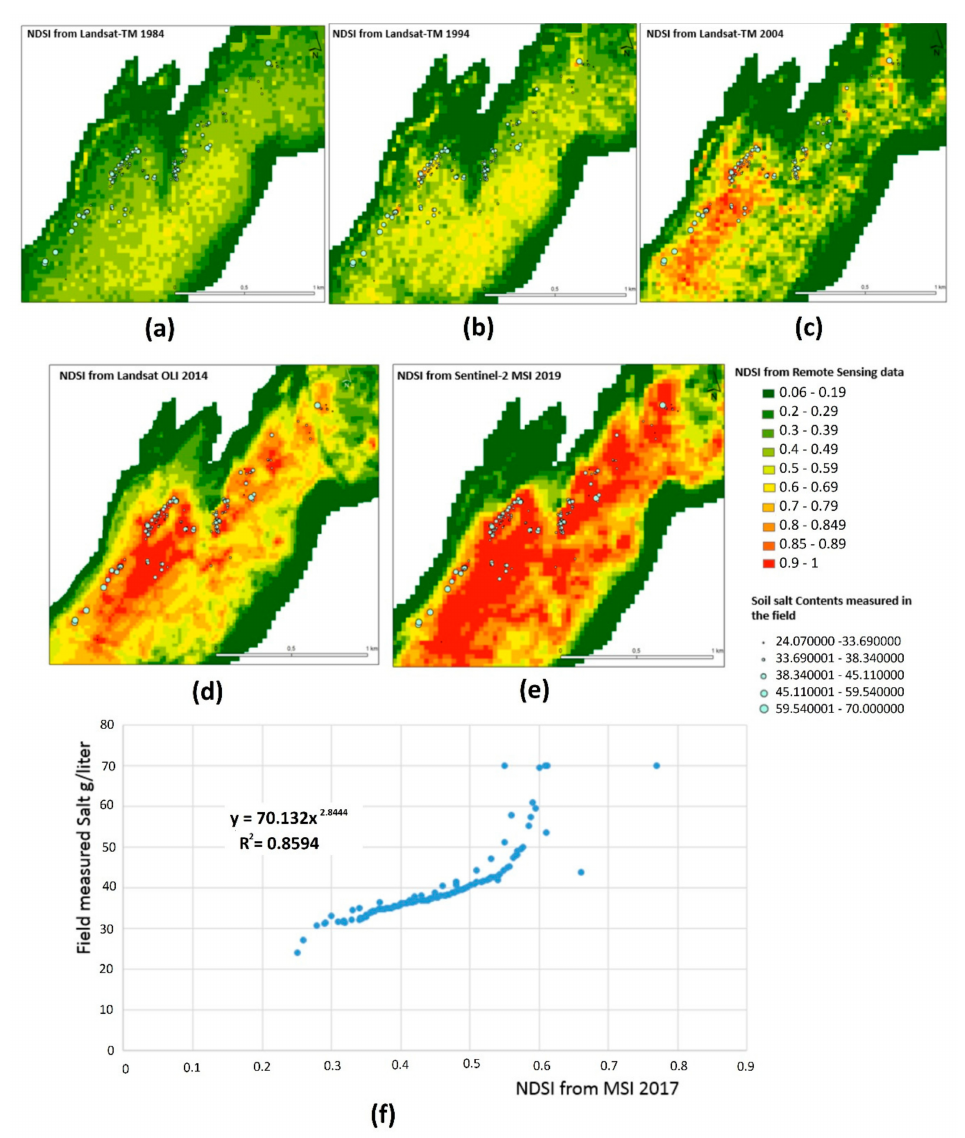
Figure 6. Monitoring of NDSI from 1984 to 2019 ( a – e ) spatial distribution and soil salinization measured in the field, and ( f ) correlation between NDSI from Sentinel-2 MSI 2017 and the salt content field